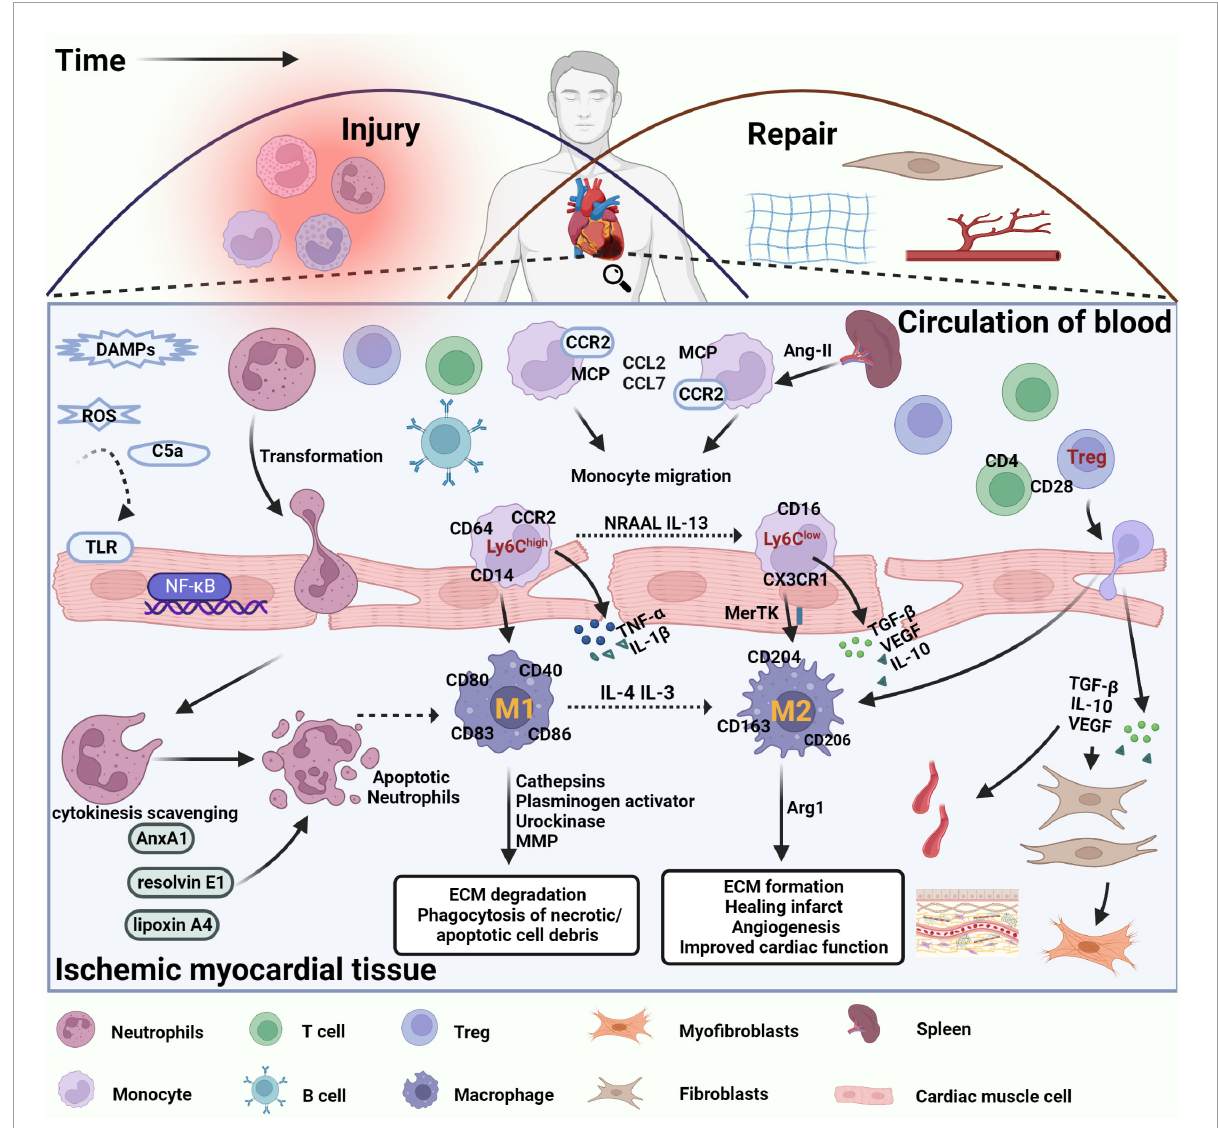
FIGURE1 Immune cells are involved in damage and repair after myocardial infarction. After MI, DAMPs are released by necrotic cardiomyocytes and damaged extracellular matrix fragments, which activate TLRs and NF- κ B signaling in cardiomyocytes, promote the release of inflammatory factors and chemokines, and leukocyte infiltration into damaged tissues. The inflammatory response is triggered by the disruption of antioxidant mechanisms, massive release of ROS, and significant activation of the complement system. Neutrophils are recruited into the infarct site within the first few minutes after MI, interact with endothelial cells via integrins and ICAM-1, perform phagocytosis of necrotic cell debris, and initiate an apoptotic program with corresponding changes on the cell surface to promote cytokine clearance and eventual clearance by macrophages. Circulating lipoxin A4, resolvin E1, and AnxA1 induce neutrophil apoptosis and stimulate macrophage polarization toward an anti-inflammatory phenotype. Apoptotic neutrophils release alpha-defensins, a cascade of proteins that increases macrophage phagocytic activity and inhibits their ability to release inflammatory factors. Therefore, clearance of apoptotic neutrophils is considered the beginning of cardiac repair after MI. In the following hours, B and T lymphocytes are also recruited to the damaged site, promoting the recruitment of circulating monocytes to the area of infarction. Monocytes in the spleen, regulated by ANG II, also migrated to the location of myocardial injury, driving CCR2-dependent monocyte migration via MCP-1 binding to CCR2 and promoting the expression of CCL2 and CCL7. Pro-inflammatory Ly6C high monocytes differentiate into proinflammatory macrophages (M1), which release inflammatory factors such as IL-1, TNF- α , and IL-12, exert phagocytosis and secrete protein hydrolases to promote digestion of tissue and clearance of necrotic debris in the infarcted region. Over time, reparative Ly6C low monocytes become the predominant subtype and differentiate into anti-inflammatory macrophages (M2) that express pro-repair mediators such as IL-10, VEGF, and TGF- β 1 to suppress the inflammatory response, promote myofibroblast proliferation, angiogenesis, and collagen fiber deposition, and promote cardiac repair after MI. In addition, regulatory T cells regulate macrophage phenotype through secretion of IL-10, VEGF, TGF- β 1, or contact-dependent pathways to facilitate the regression of cardiac inflammation and improve cardiac function after